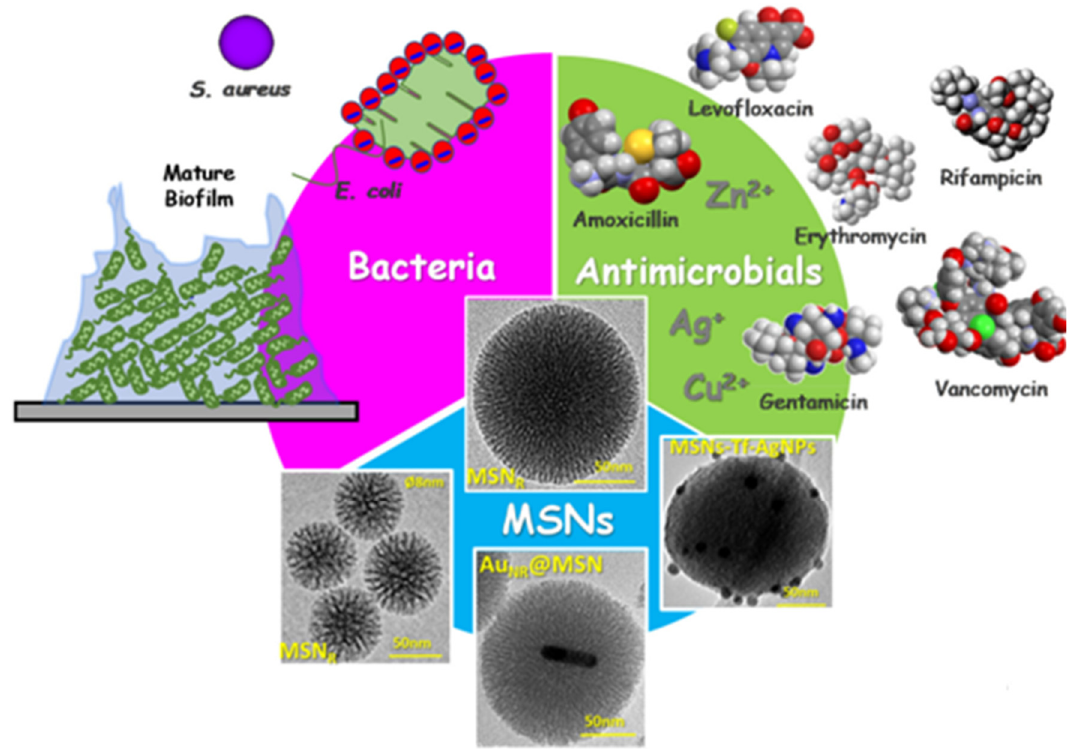
Figure 2. Schematic depiction of the three main actors starring in the innovative scientific approaches developed by Vallet ‐ Regí et al. in the design and engineering of nanoantibiotics for the treatment of infections: bacteria, antimicrobial agents, and MSNs. MSNR: Radial mesoporous silica nanoparticles; AuNR@MSN: gold nanorods@mesoporous silica nanoparticles; MSN ‐ Tf ‐ AgNPs: mesoporous silica nanoparticles decorated with transferrin and silver nanoparticles. Reprinted from ref. [66].